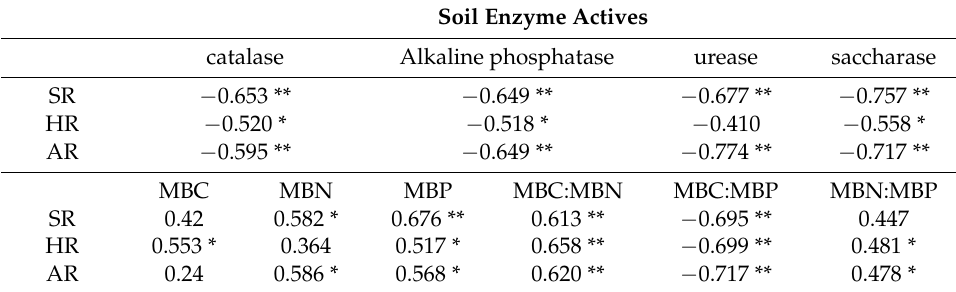
Table 3. Spearman’s rank correlation coefficients between the microbial biomass (C, N, and P) and its stoichiometry (MBC:MBN, MBC:MBP and MBN:MBP) and the soil enzyme actives (catalase, saccharase, urease, and alkaline phosphatase), as well as soil respiration components.